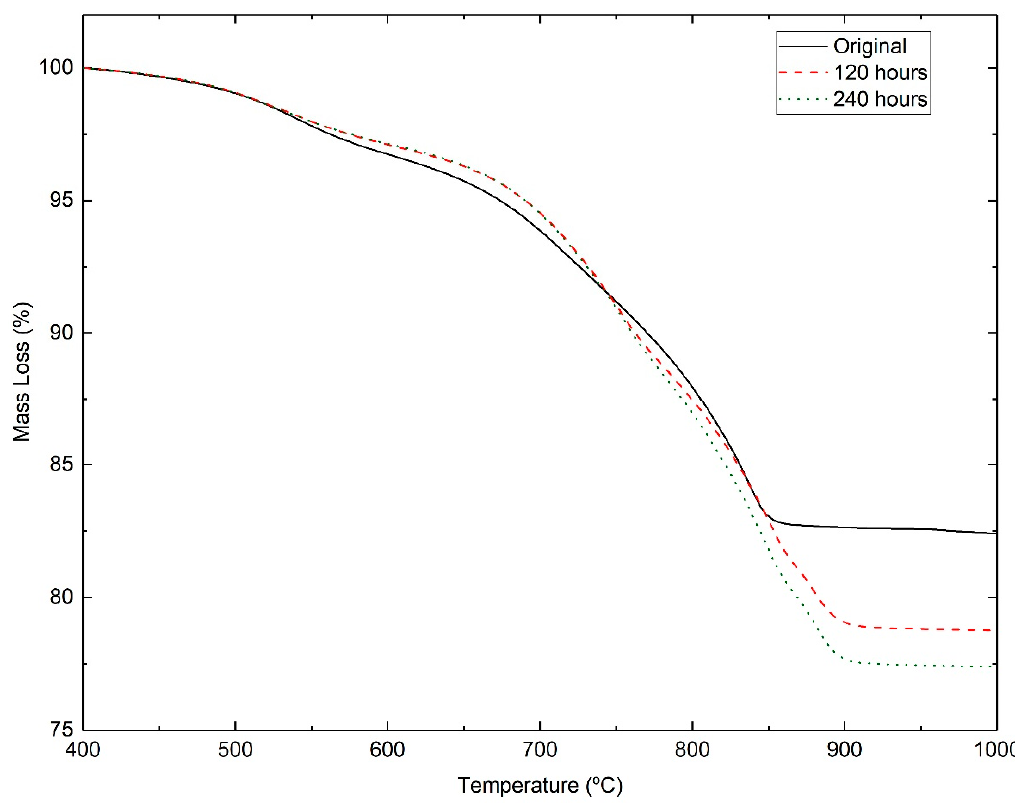
Figure 5. Thermogravimetric analysis of the original sample (solid line) and treated samples at 120 h (dash line) and 240 h (dotted line).